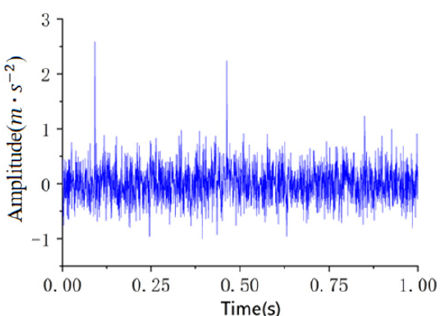
Figure 16. Time domain diagram of the original vibration signal after preprocessing.